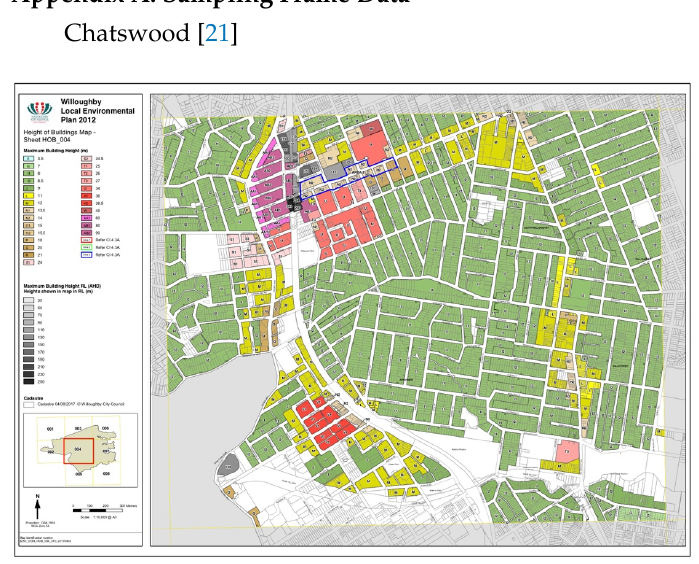
Figure A1. Chatswood Height of Building LEP.